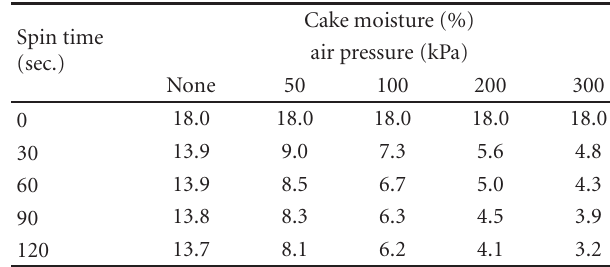
Table 7: E ff ects of G -force and air pressure on the dewatering of